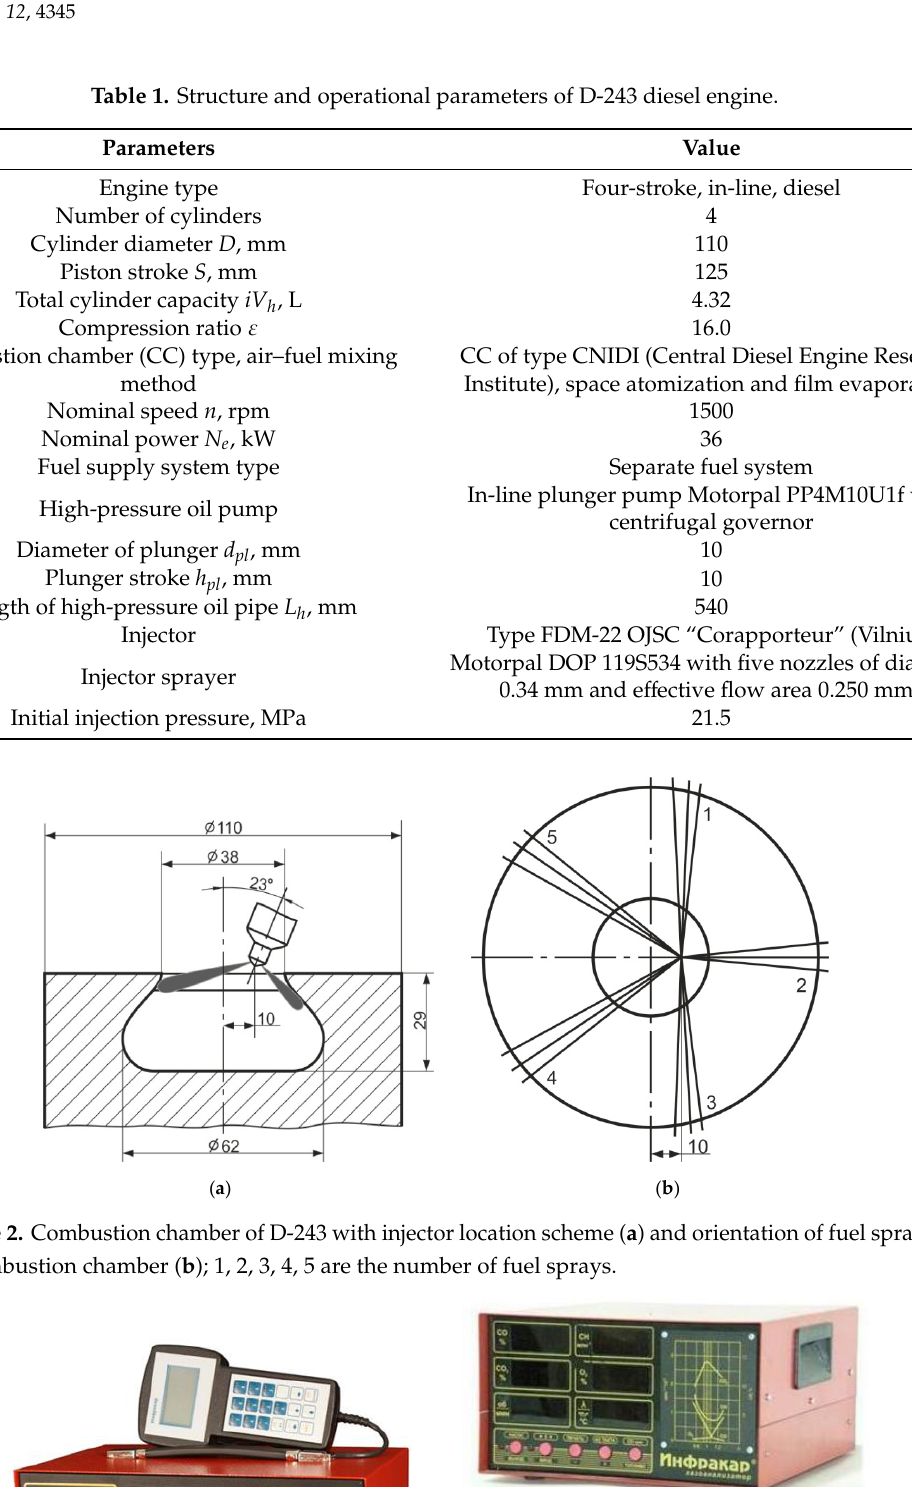
Table 1. Structure and operational parameters of D-243 diesel engine.